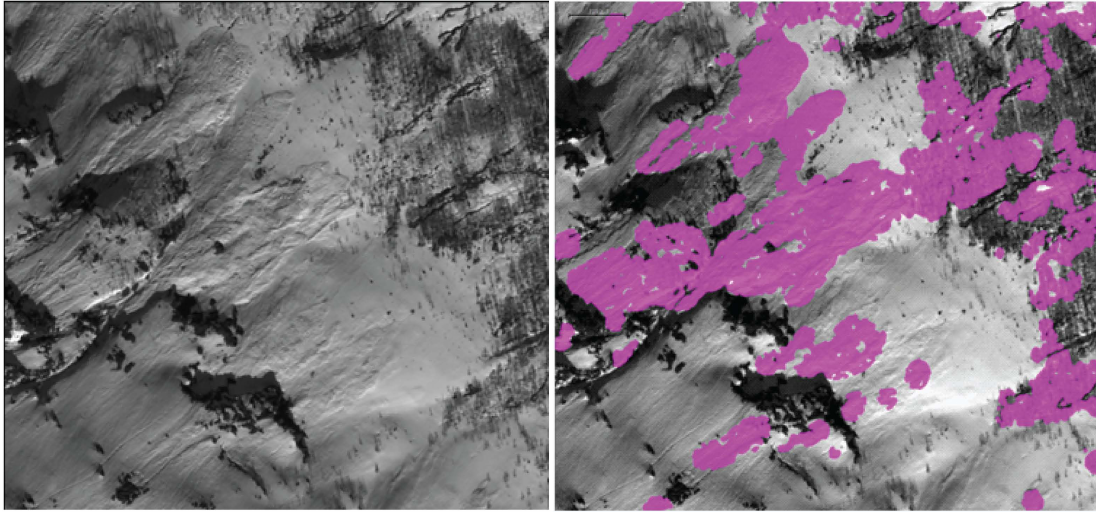
Fig. 12. QuickBird imagery over the Dalsfjord region, raw image (a) overlain by automatically identified avalanches (b) . The avalanches in the right-hand image are correctly identified; however, regions of the image characterised by snow and sparse deciduous trees are falsely identified as avalanches as